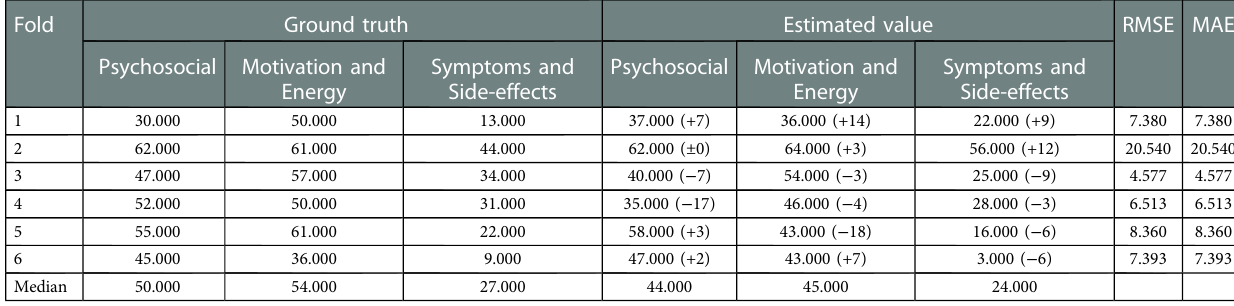
Table 10 First and second measurements (ground truth), and estimation scores a from longitudinal measurements. Fold Ground truth Estimated